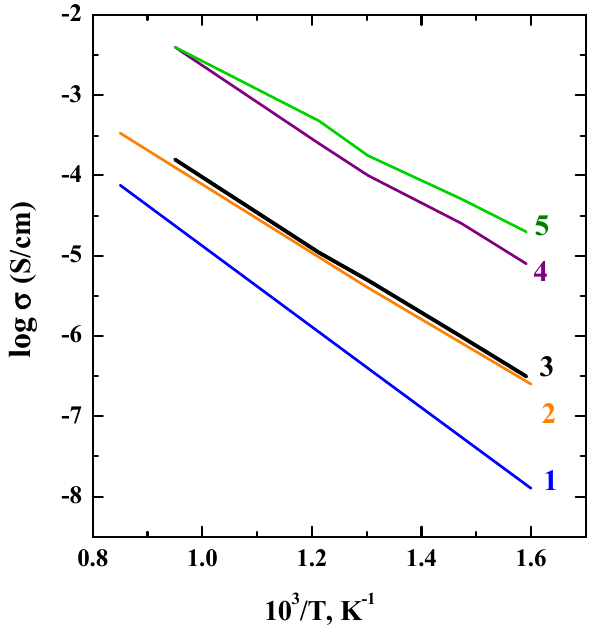
Figure 7. The temperature dependencies of electrical conductivities of the compositions SrLaInO 4 (1) [70]; SrLaIn 0.8 Zr 0.2 O 4+d (2) [70]; Sr 1+ x La 1 − x InO 4 − d , x = 0 (3), x = 0.1 (4), x = 0.2 (5) [66].